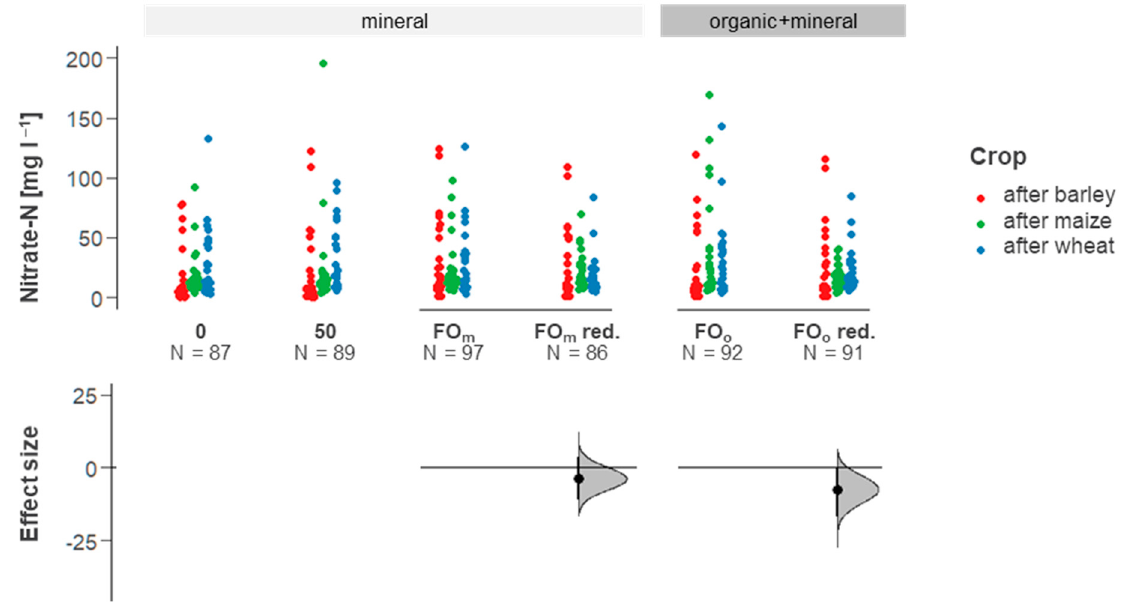
Figure 4. Estimation plot and effect sizes for NO 3 -N concentrations under different fertiliser treatments and direct comparisons between fertiliser ordinance recommended (FO) vs. reduced (FO red.) fertilisation by fertiliser type (m: only mineral, o: combined organic + mineral) for all experimental seasons (N: sample size). Table 4. Effect size (ES, mean difference) with 95% confidence intervals of reduced vs. recommended N-fertilisation for only mineral and combined organic and mineral applications for all crops over three years (N: sample size reduced/normal fertilisation; *: significant difference).